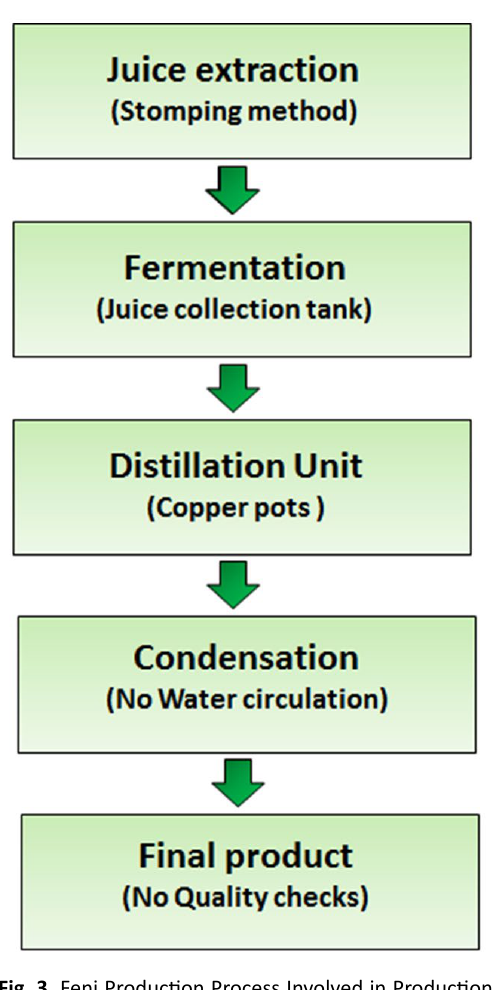
Fig. 4. Feni Production Process Involved in Production